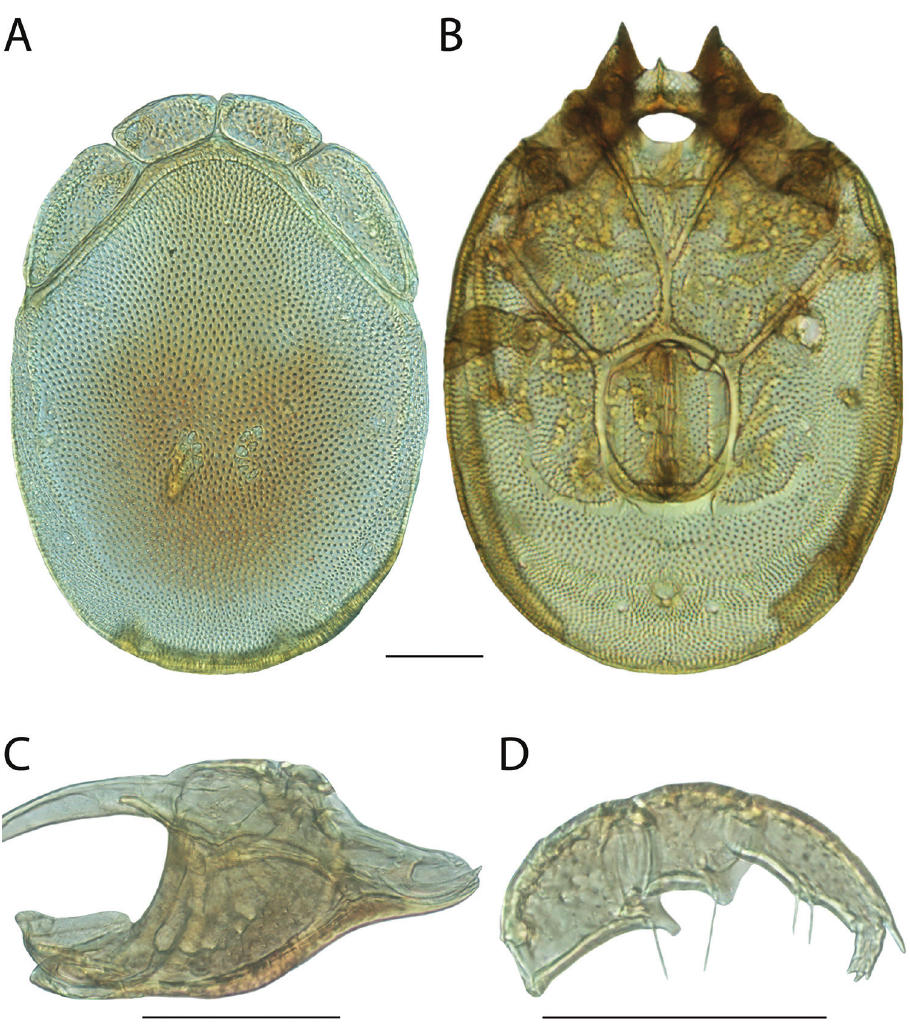
Figure 177. Torrenticola olliei sp. n. male: A dorsal plates B venter (legs removed) C subcapitulum D pedipalp (setae not accurately depicted). Scale = 100